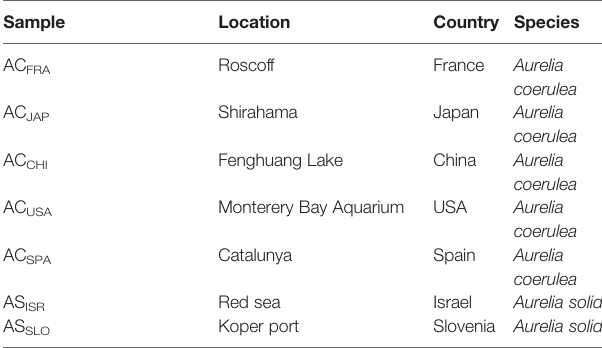
TABLE 1 | The native locations of Aurelia